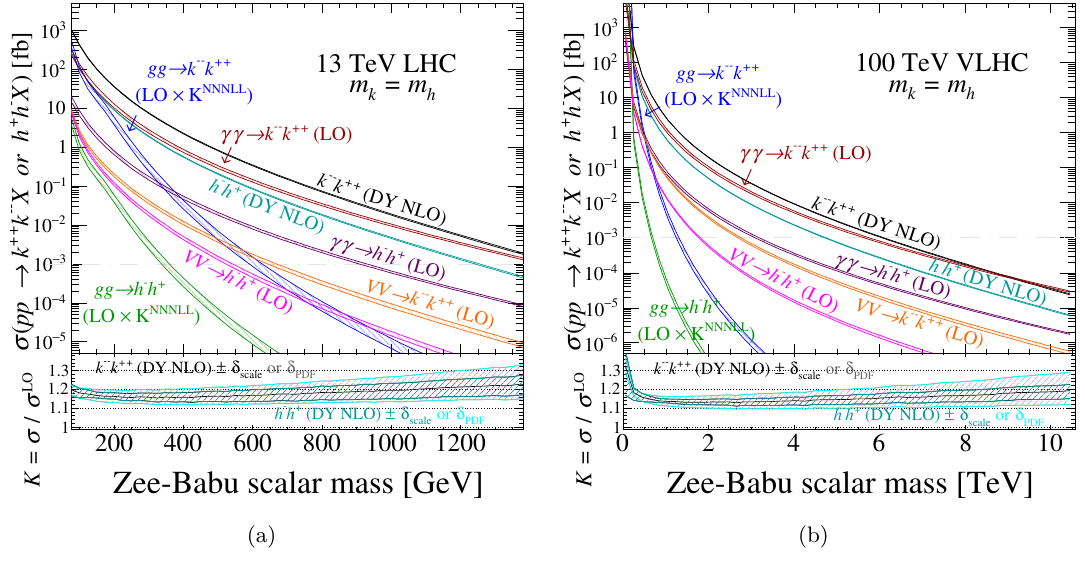
Figure 3 . (a) Upper panel: as a function of scalar mass, production-level cross sections at residual √ scale uncertainties at the s = 13 TeV LHC of k −− k ++ and h − h + pairs, as predicted by the Zee-Babu model, via the Drell-Yan mechanism (DY) at NLO in QCD, γγ fusion (AF) at LO, loop- induced gg fusion (GF) channel scaled by an N 3 LL K -factor [98], and EW vector boson scattering ( V V ) at LO with phase space cuts. Lower panel: the ratio of the NLO and LO DY cross section with scale uncertainty (inner band) and PDF uncertainty (outer band). (b) Same as (a) but for √ s = 100 TeV . Cross sections assume the SM inputs of section 3.2 as well as the Zee-Babu inputs of eqs. (3.4) and